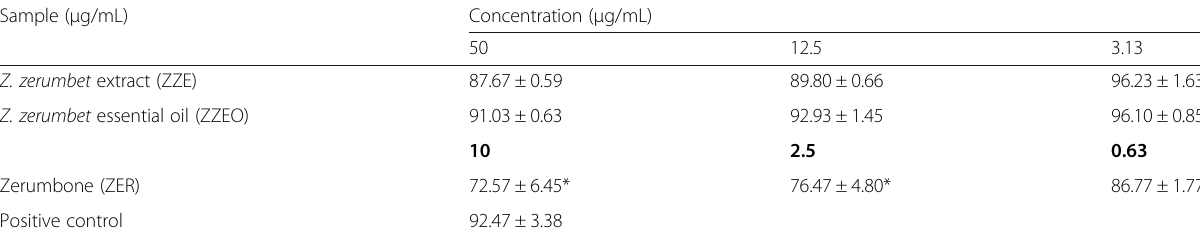
Table 2 Percentage of CD11b/CD18 expression activity (%) of neutrophils at different concentrations of test samples derived from Zingiber zerumbet